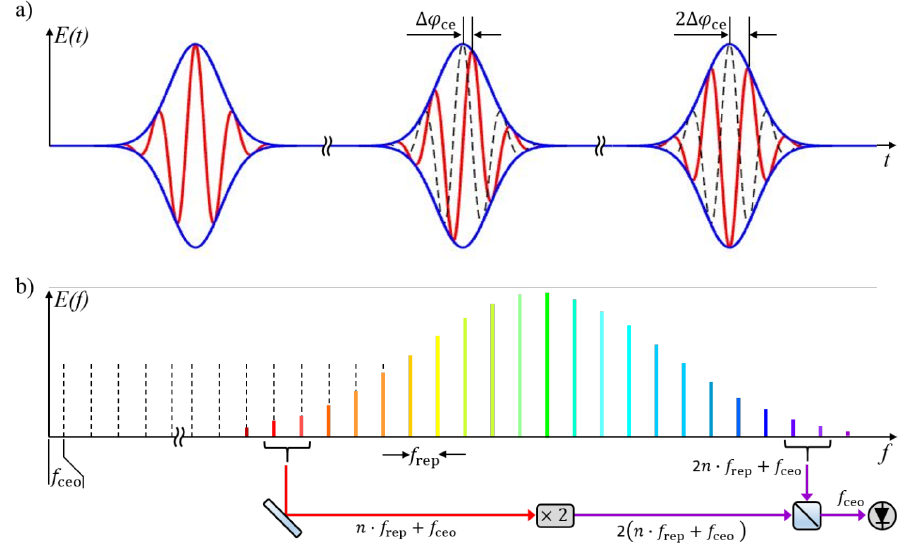
Figure 1: Optical pulse train and spectrum emitted by a mode-locked laser. a) The carrier wave (red) and the pulse envelope (blue) travel with different phase and group velocities, respectively, leading to a carrier-envelope phase shift, ∆φ ce , from pulse to pulse. b) The optical spectrum of a mode-locked laser is comprised of individual frequency teeth separated by the repetition rate, f rep , of the laser. Extrapolating the spectrum to frequency zero reveals the offset, f ceo = f rep ∆φ ce /(2 π ) , which can also be regarded as the tooth at mode number n = 0 . Also shown is the standard method of detecting f ceo through an f-to-2f interferometer [5,